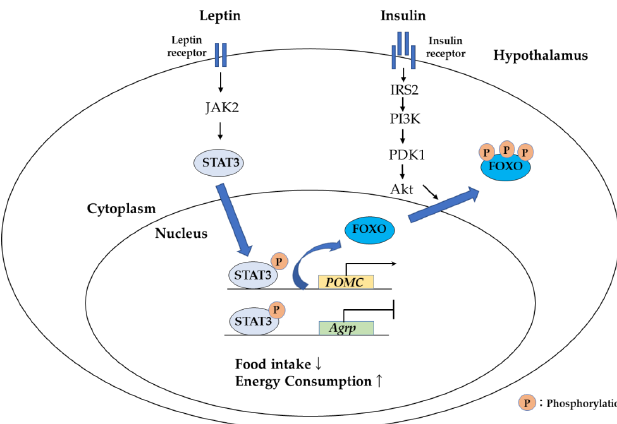
Figure 11. Food intake regulation by insulin and leptin in the hypothalamus. Insulin and leptin signaling decreases food intake and increases energy consumption. FOXO1 and STAT3 function antagonistically by competing for the binding sites on the promoter region of Pomc and Agrp genes. PDK1, 3-phosphoinositide-dependent protein kinase 1.